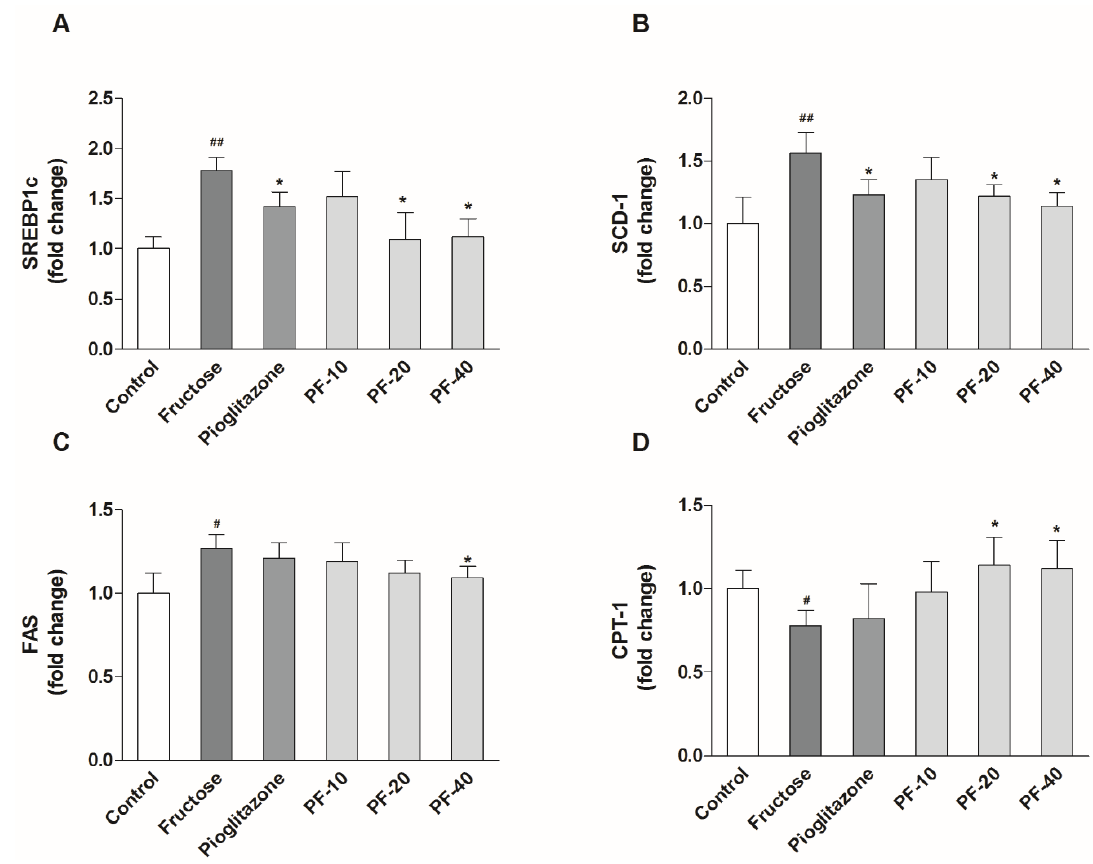
Figure 4. Effects of paeoniflorin on the mRNA expression of SREBP1c, SCD-1, FAS and CPT-1 in liver. ( A ) The mRNA expression of SREBP1c. ( B ) The mRNA expression of SCD-1. ( C ) The mRNA expression of FAS. ( D ) The mRNA expression of CPT-1. Data were normalized by the abundance of GAPDH and expressed as the relative value to control. Data were expressed as the mean ± S.E.M. ( n = 6) and analyzed by one-way ANOVA followed by Dunnett’s post hoc test. # p < 0.05 and ## p < 0.01 vs. control group. * p < 0.05 vs. fructose group. PF-10: 10 mg/kg of paeoniflorin; PF-20: 20 mg/kg of paeoniflorin; PF-40: 40 mg/kg of paeoniflorin. SREBP1c: Sterol regulatory element-binding protein 1c; SCD-1: Stearyl coenzyme A decarboxylase; FAS: Fatty acid synthetase; CPT-1: Carnitine palmitoyltransferase I.